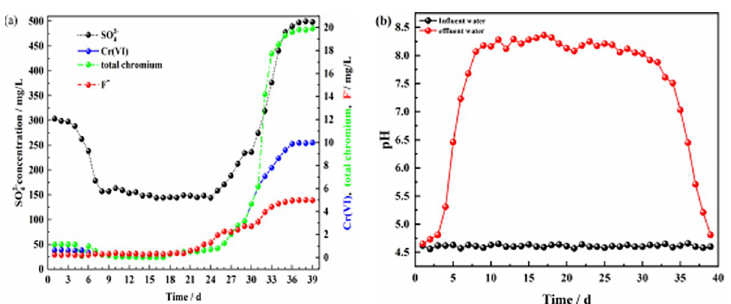
Fig 8. Effluent of dynamic column #3. (a) Effluent concentration of each pollutant ion; (b) pH values of influent and effluent water.